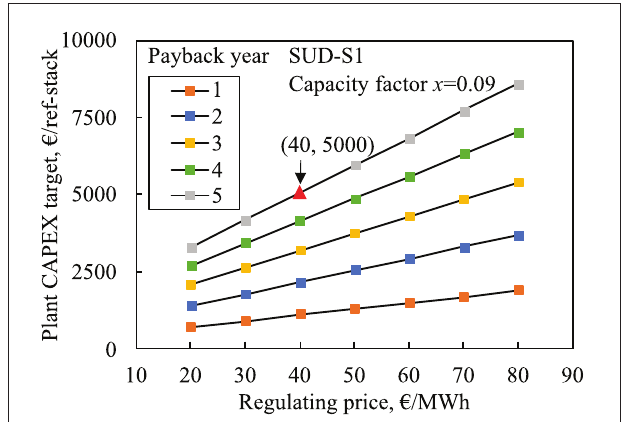
FIGURE 11 | Plant CAPEX target with different payback years and regulating prices for the cases of SUD-S1. balancing service occurring before reaching the set payback